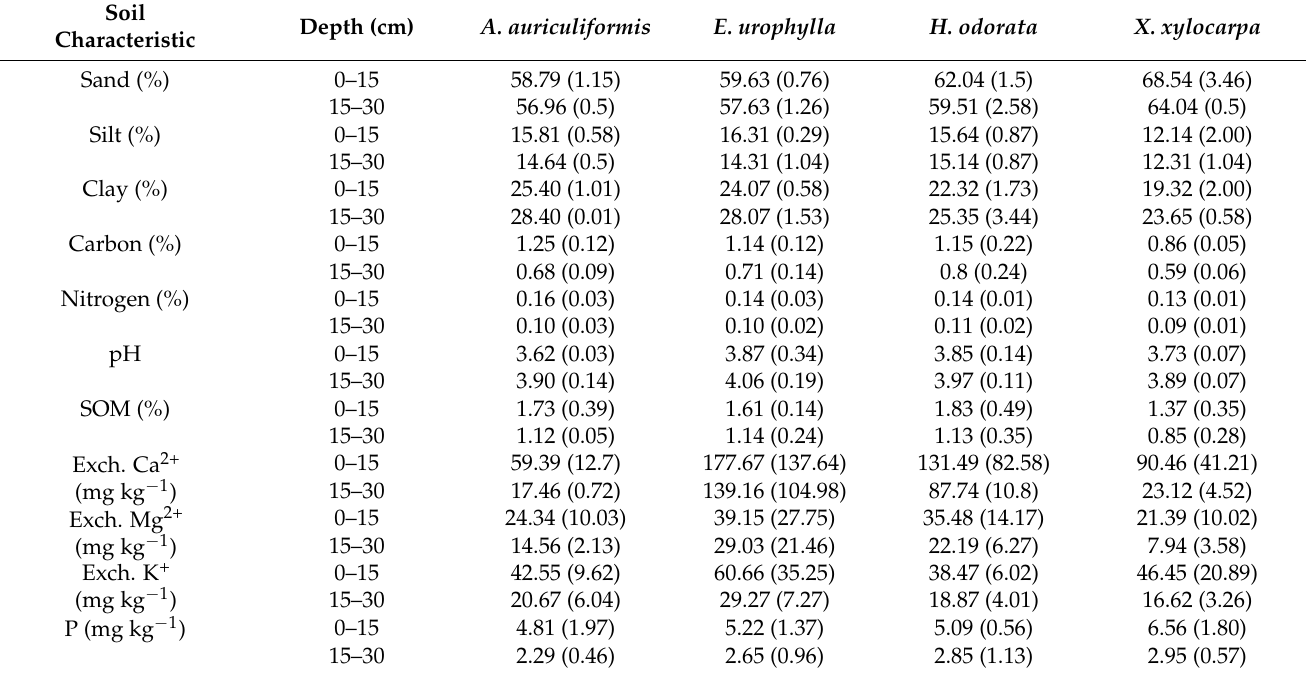
Table A1. Mean and standard deviation of soil properties by type and depth in four plantation plots. Soil properties include physical properties (sand (%), silt (%), and clay (%)), chemical properties (car- bon (%), nitrogen (%), pH, and soil organic matter (%)), and nutrient properties (exchangeable cations of calcium (mg kg − 1 ), magnesium (mg kg − 1 ), potassium (mg kg − 1 ), and phosphorus (mg kg − 1 ), which were determined following the methods described by [68–70]).